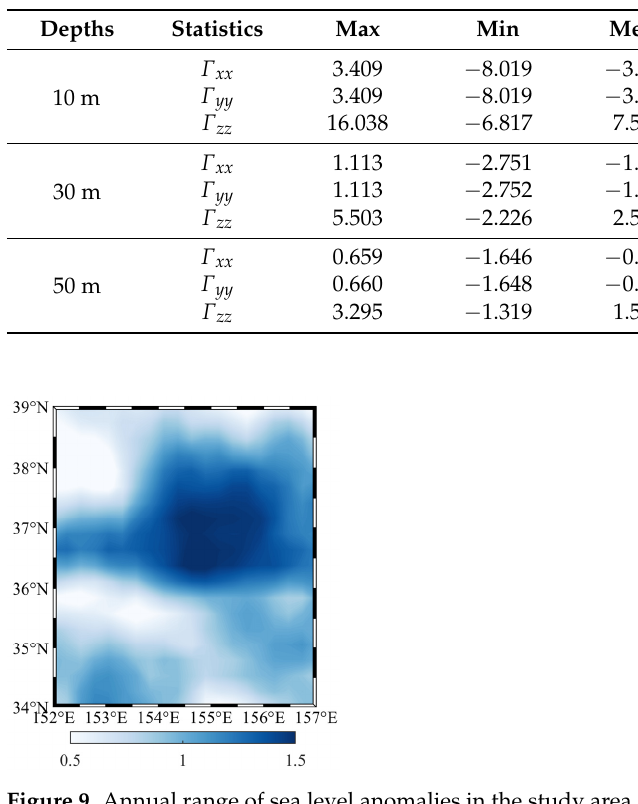
Figure 8. Disturbing gravity gradient at 10 m below mean sea level (unit: E). Table 5. Statistics of the disturbing gravity gradient at different depths below the mean sea level (unit: E).